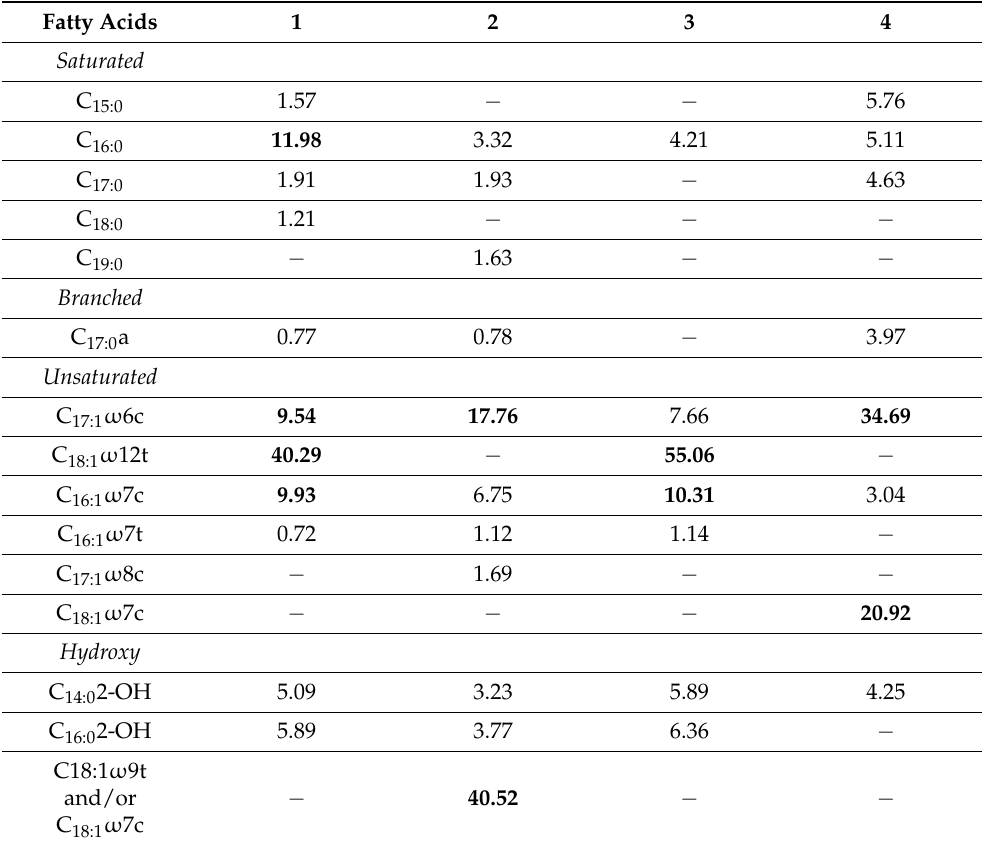
Table 1. Fatty acids profiles of strain NZ-96 T and the phylogenetically closest relatives. Strains 1: NZ-96 T ; 2: Qipengyuania citreus RE35F/1 T ; 3: Erythrobacter aureus YH-07 T ; and 4: Qipengyuania pelagi UST081027-248 T . Values are percentages of the total fatty acids. The bold type represents the